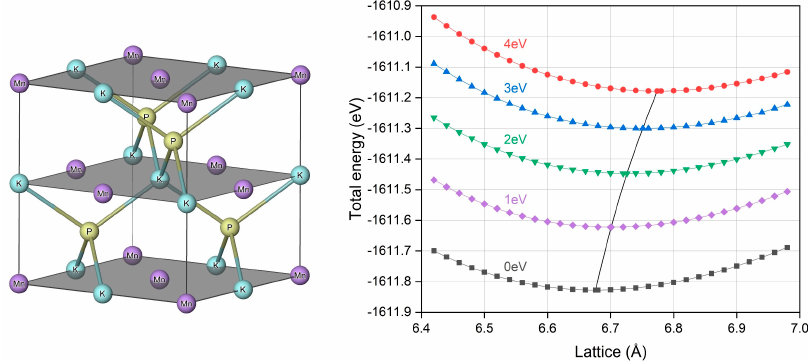
Figure 1. The crystal structure of half Heusler compound MnPK and the calculated total energy under different lattice constants with different Hubbard U values.